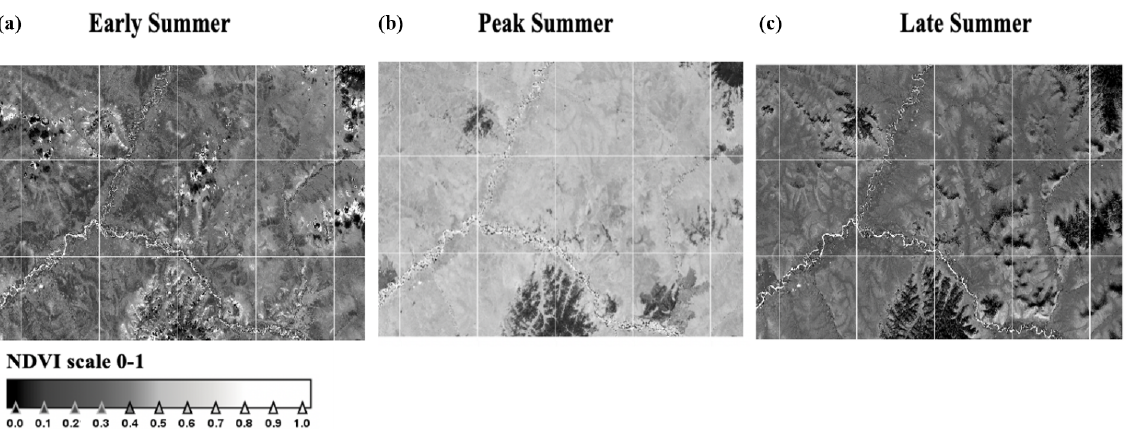
Figure 10. Sentinel-2 NDVI in greyscale of the three periods for the Bilibino subregion in Chukotka: (a) early summer, (b) peak summer, and (c) late